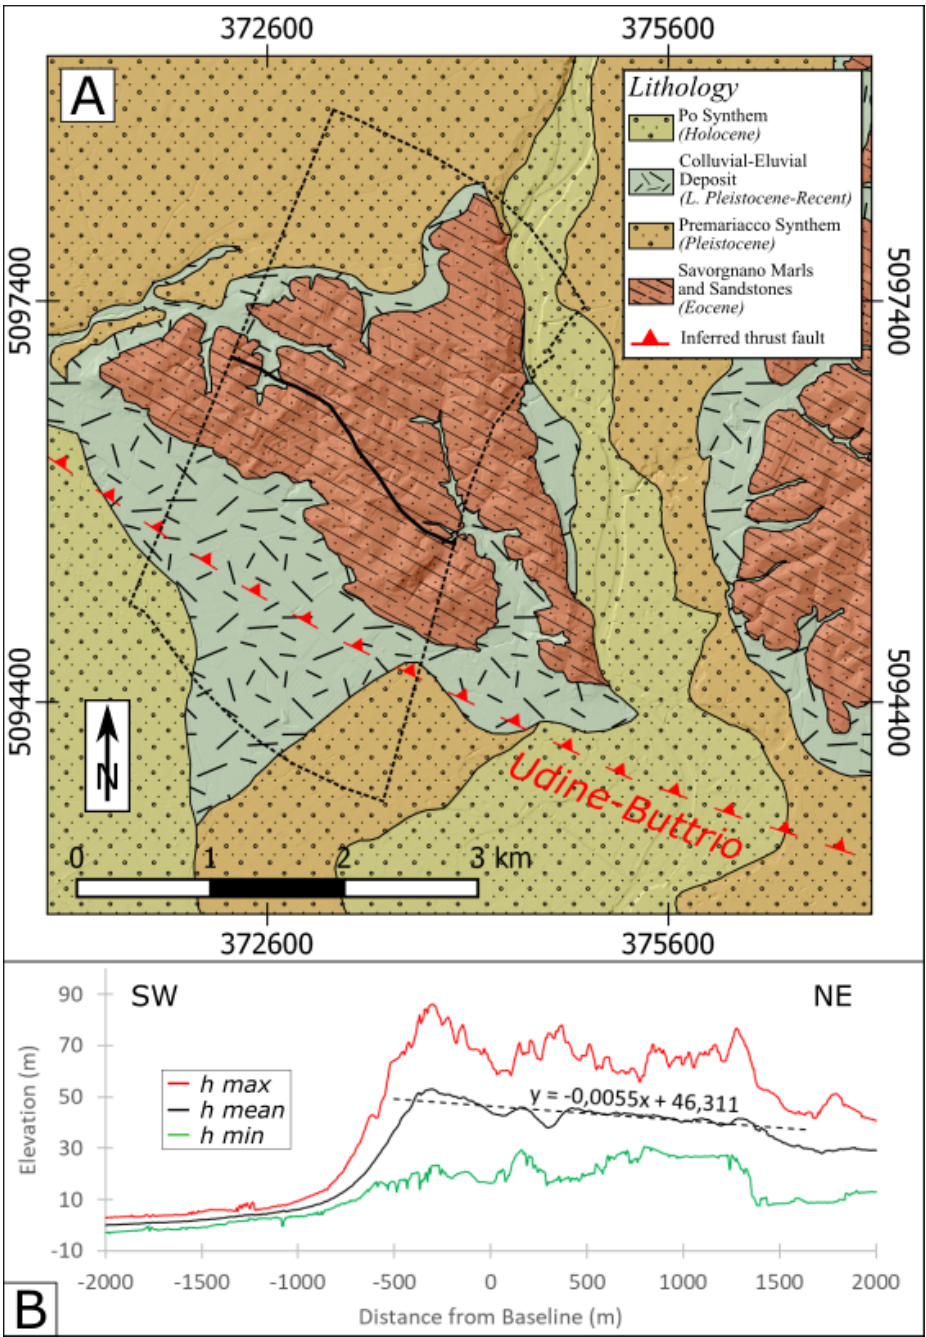
Figure 4. ( A ): Geological sketch of the study area. The black dashed polygon represents the boundary of the swath profile analyzed with QGIS. The black full line represents the baseline of the same profile. ( B ): Outcome of the swath profile extraction. The green, black and red lines are the minimum, mean and maximum elevation values, respectively. The regression line is calculated assuming the origin of the coordinate system at the baseline. Vertical exaggeration 13 :